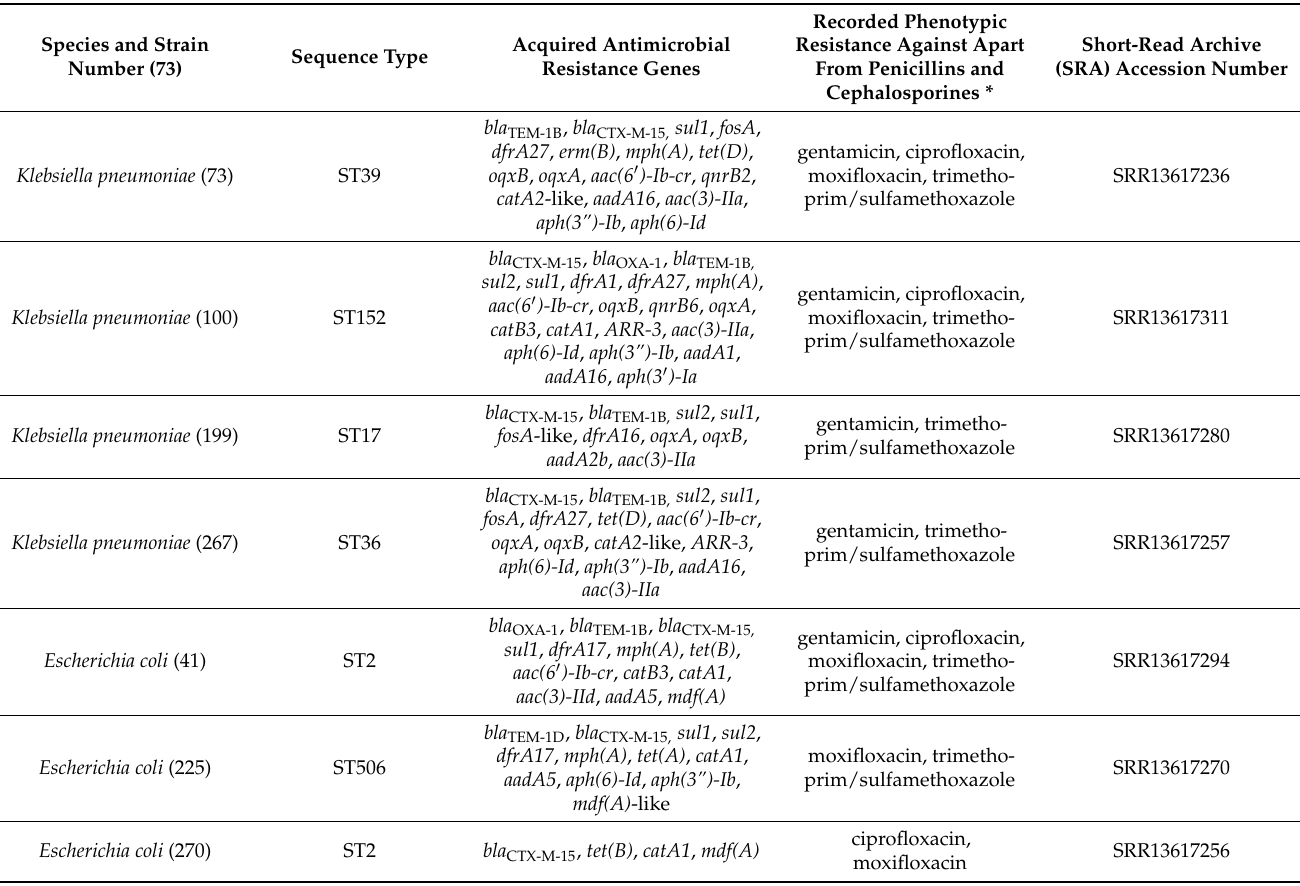
Table A2. Strain-specific details of the 7 Enterobacterales included in the screening for mobile genetic elements mediating antimicrobial resistance. Further details are provided elsewhere